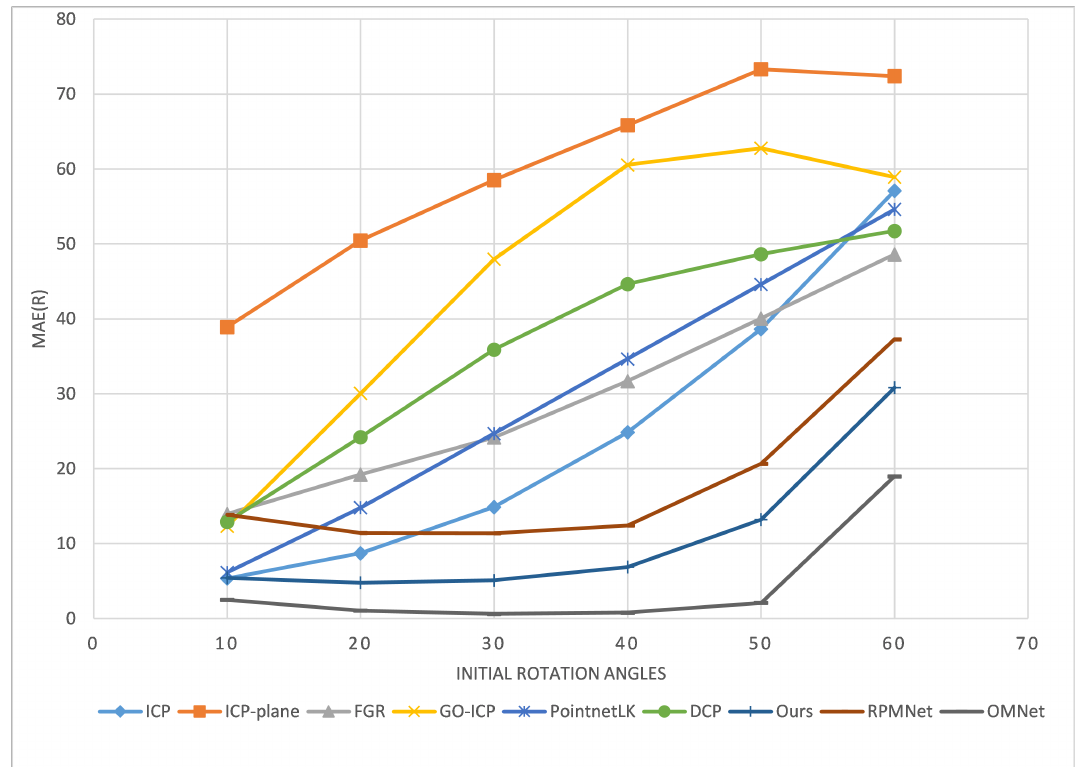
Figure 7. Influence of different initial angles on MAE ( R )